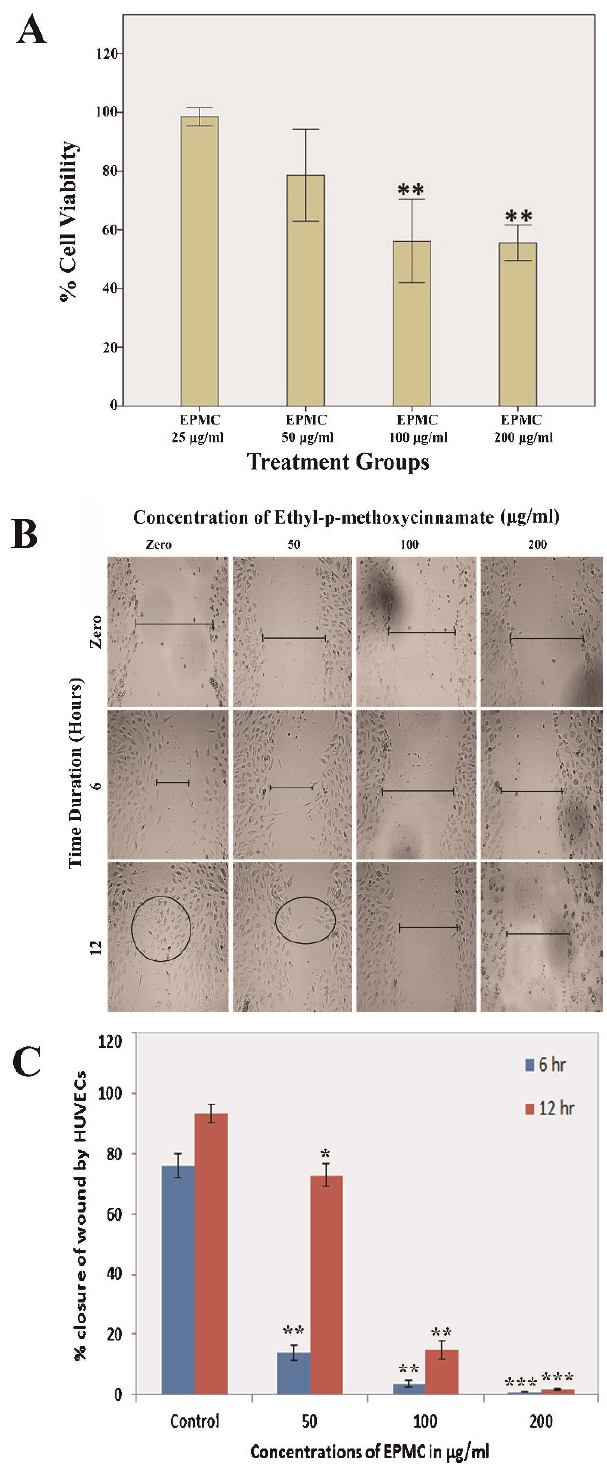
Figure 3 - The effects of ethyl- p -methoxycinnamate (EPMC) on proliferation and migration of human umbilical vein endothelial cells (HUVECs). A ) Graphical representation of the inhibitory effect of EPMC on the percent of viable HUVEC cells at concentrations of 25, 50, 100, and 200 m g/ml. B ) The inhibitory effects of EPMC on cell migration in HUVECs. Images were taken under an inverted phase-contrast microscope at 4 6 magnifica- tion after 0, 6, and 12 hours of incubation. Straight lines